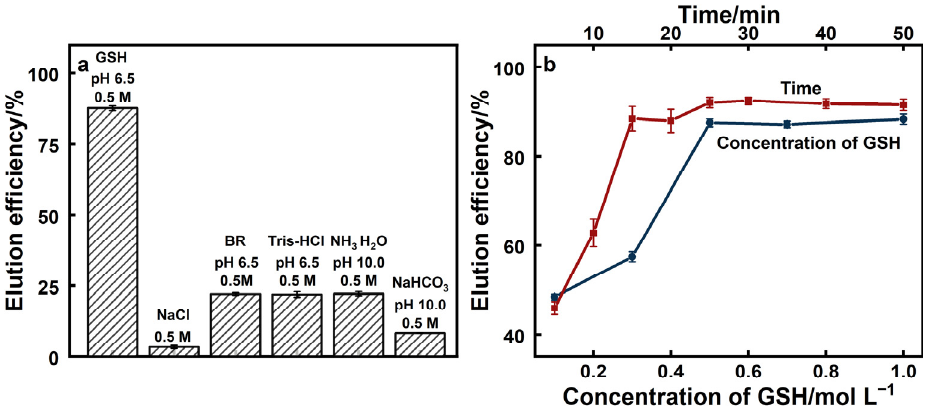
Figure 7. ( a ) The elution efficiencies of adsorbed GST from GPG with different stripping reagents. GST solution: 1.0 mL and 100 mg L − 1 ; adsorption time: 30 min; elution time: 20 min; mass of adsorbent: 1.0 mg. ( b ) The elution efficiencies of adsorbed GST from GPG under different GSH concentrations and elution times. GST solution: 1.0 mL and 100 mg · L − 1 ; adsorption time: 30 min; mass of adsorbent: 1.0 mg.